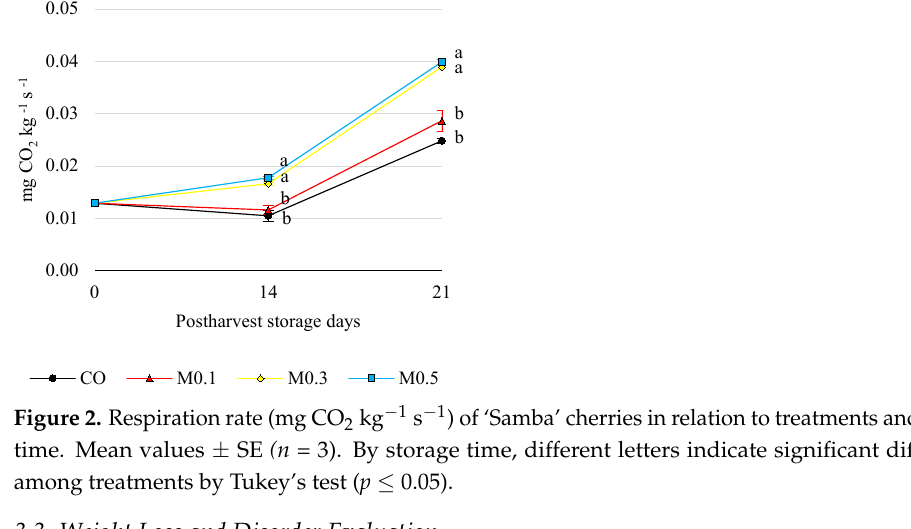
Table 2. Mean scores obtained in the sensory evaluation of ‘Samba’ cherries in relation to treatments and storage time.